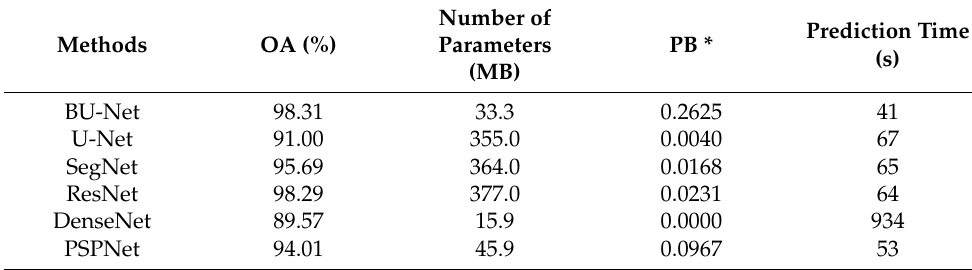
Table 5. PB values of different